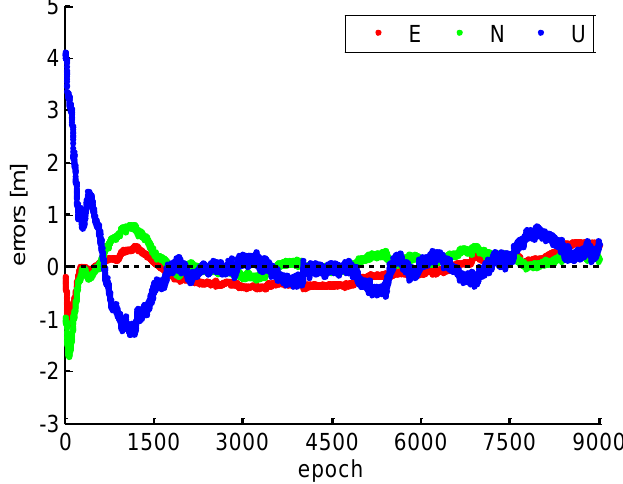
Figure 16. Position errors with the proposed cycle slip fixing method.